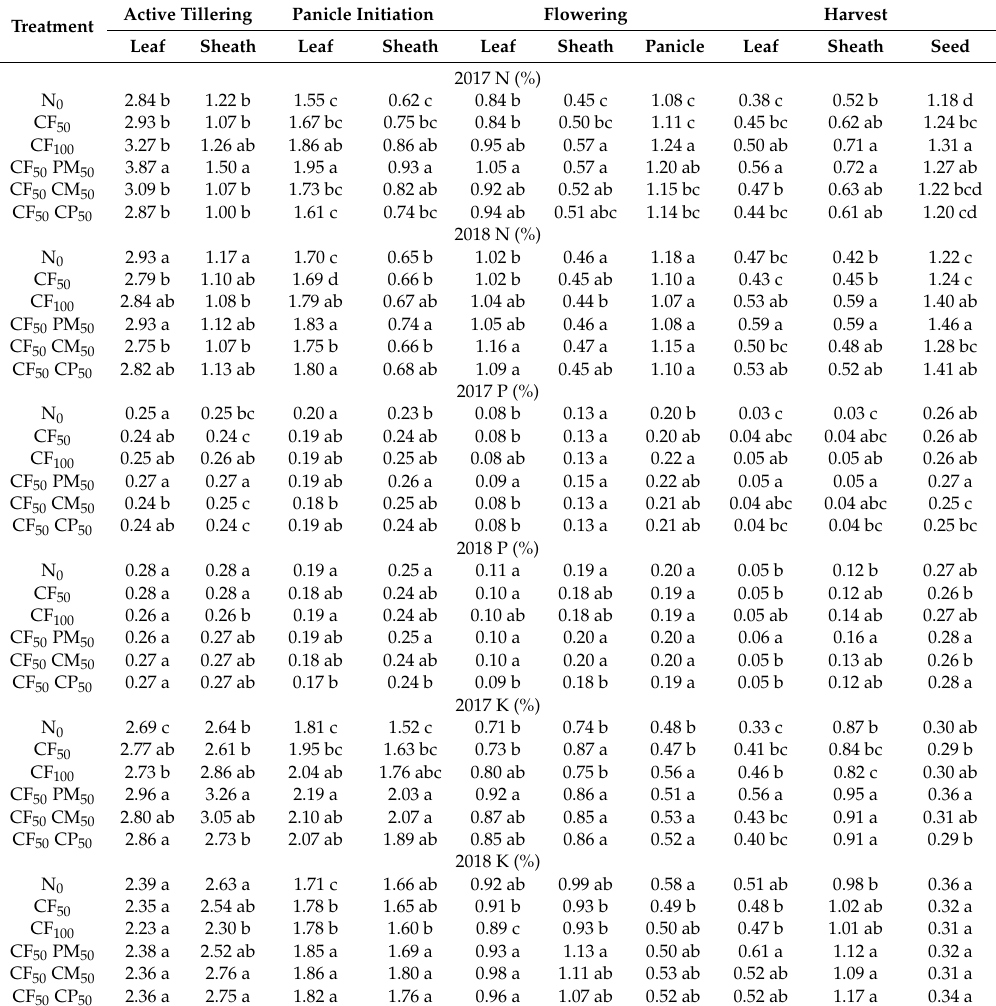
Table 3. N, P and K contents (%) of leaf, sheath, panicle and seeds of rice variety Manawthukha a ff ected by organic fertilizer at the critical growth